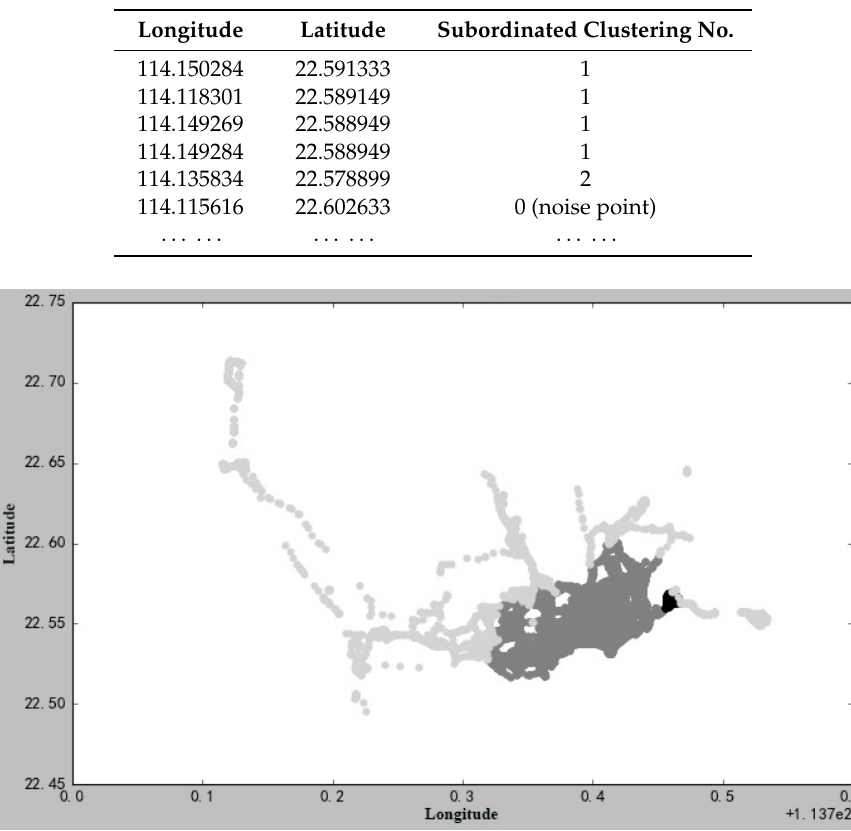
Figure 24. The trajectory distribution of the original data before clustering.